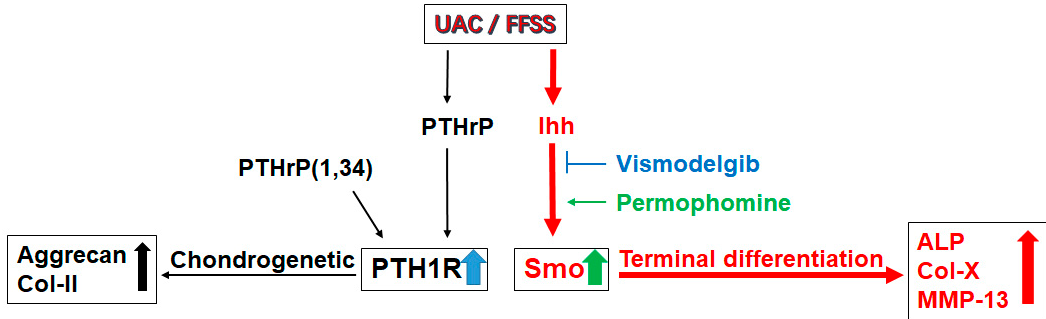
Figure 9. The summary of the present story. Both UAC and flow fluid shear stress (FFSS) stimulated section of PTHrP and Ihh, and promoted chondrocytes differentiation, which reduced the number of PTH1R expressing chondrocytes.